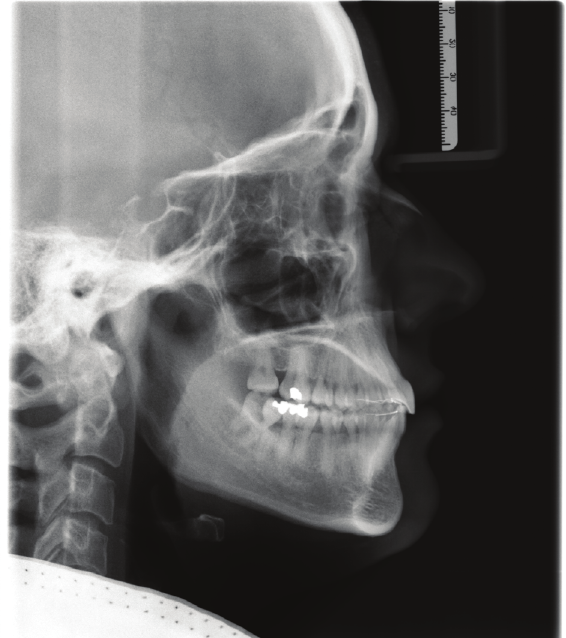
Figure 13. Lateral cephalogram immediately after debonding and completion of active orthodontic treatment.